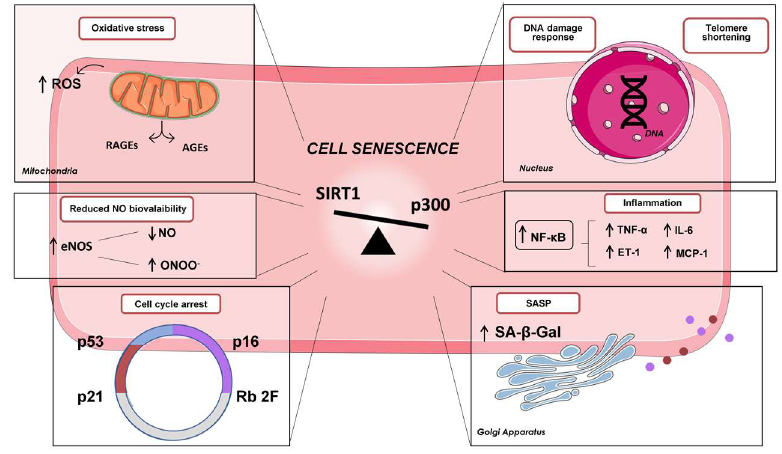
Figure 1. Endothelial cell senescence: Senescence is triggered by various stimuli, including changes in telomeric structure, oxidative stress, mitochondrial dysfunction, inflammation and DNA damage, which contribute to cell cycle arrest through the activation of the p53/p21CIP1 or p16INK4A/hosphor- Rb tumour suppressor pathways. In addition, senescent cells exhibit activation of the senescence-associated secretory phenotype (SASP) characterised by the increased lysosomal activity and accumulation of β-galactosidase. The SASP leads to the upregulation and release of growth factors, cytokines and proteases that can exert detrimental effects.